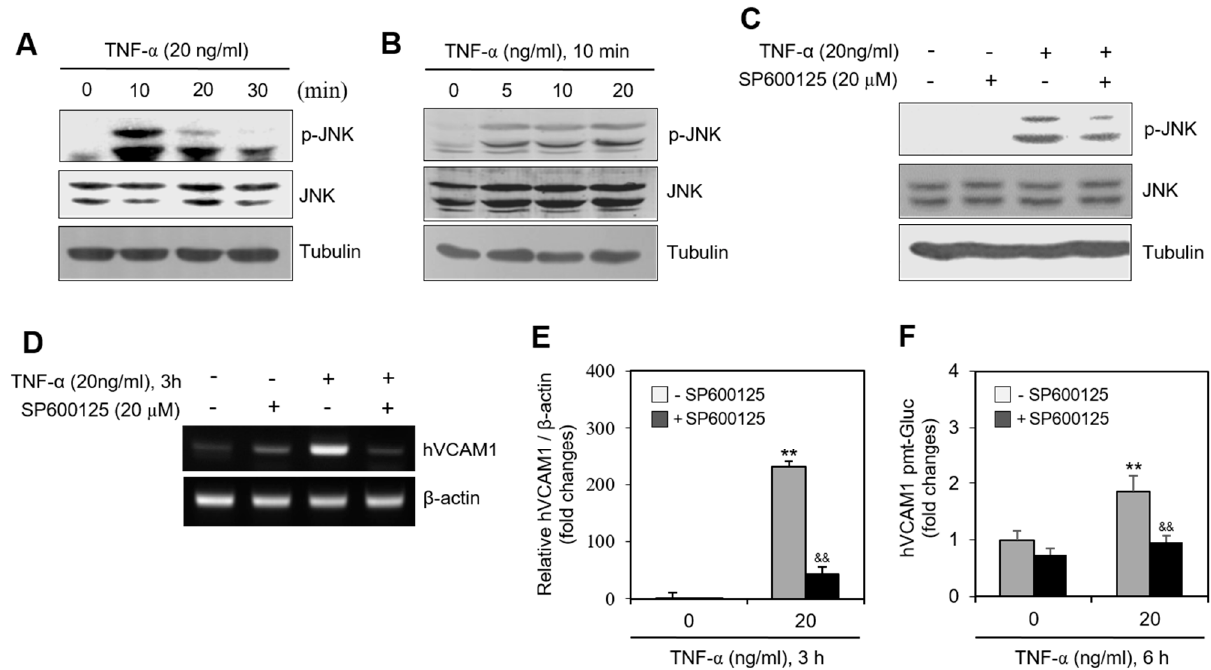
Figure 5. JNK activation by TNF- α regulated human vascular cell adhesion molecule-1 (hVCAM1) expression. ( A , B ) MH7A cells were treated with 20 ng/mL TNF- α for various times ( A ). MH7A cells were treated with various concentrations of 20 ng/mL TNF- α for 10 min ( B ). JNK and phosphorylated (p)-JNK were measured by western blot analysis. ( C , D ) MH7A cells were treated with 20 ng/mL TNF- α in the presence or absence of SP600125, JNK inhibitor. were used for inhibition of JNK activation and 20 µ M of SP600125 had strong ability of inhibition of JNK activation. Cell lysates were prepared and protein level of JNK and p-JNK was detected by western blot analysis ( C ). RNA was purified with Nucleozol ® . hVCAM1 and hBAFF expression was detected by RT-PCR ( D ). ( E ) MH7A cells were transfected with pEZx-PG02-hVCAM1-gaussia luciferase (Gluc) plasmid DNA by using polyethylenimine (PEI), and treated with TNF- α in the presence or absence of SP600125. Gluc activity was measured by using luminometer. ( F ) MH7A cells were treated with 20 ng/mL TNF- α for 6 h in the presence or absence of SP600125. Then, WiL2-NS cells were added and co-incubated to adhere for 30 min. Unbound WiL2-NS B cells were washed out and MTT assay was used to analyze bound B cells. Each experiment was performed at least four times. Data in a bar graph represent the means ± SD. ** p < 0.01; significantly different from SP600125-untreated and TNF- α -untreated control group. && p < 0.01; significantly different from SP600125-untreated and TNF- α -treated control group ( E , F